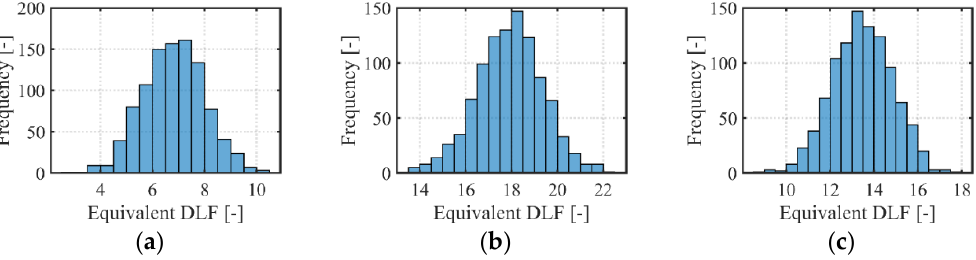
Figure 8. Equivalent DLF histogram of the first harmonic.